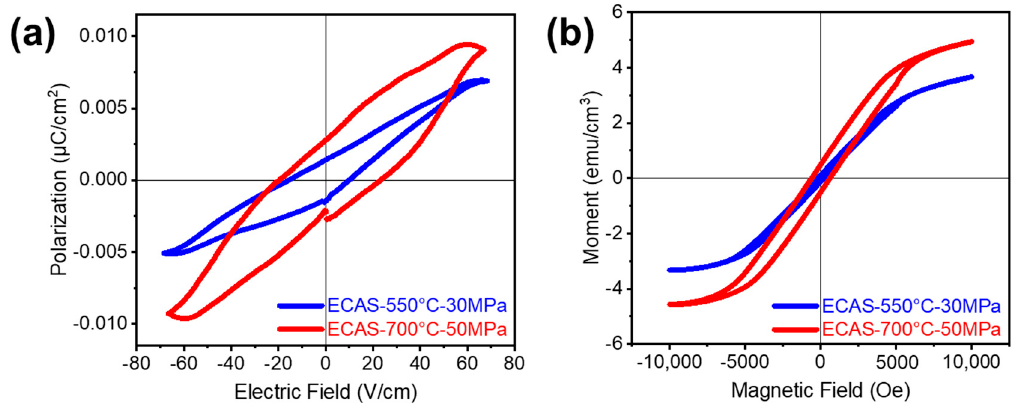
Figure 6. Room temperature ( a ) polarization electric field (P-E) and ( b ) magnetization magnetic field (M-H) hysteresis loops of ECAS-550 °C-30 MPa and ECAS-700 °C-50 MPa.